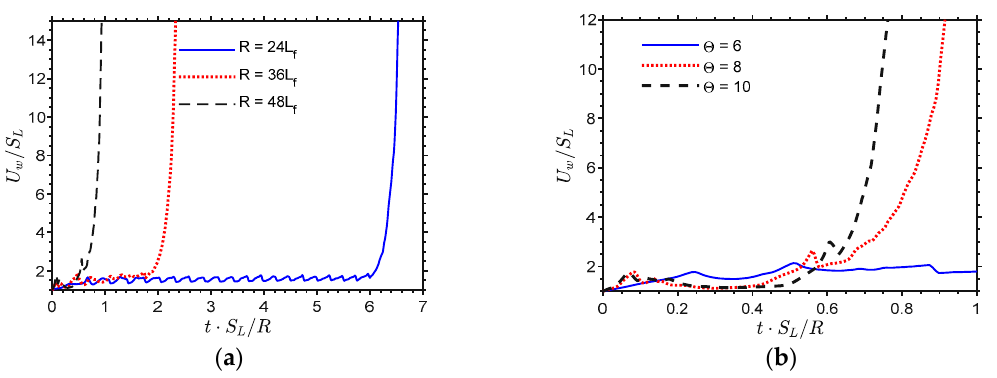
Figure 9. The scaled burning velocity U w / S L versus the scaled time τ = tS L / R for burning in the